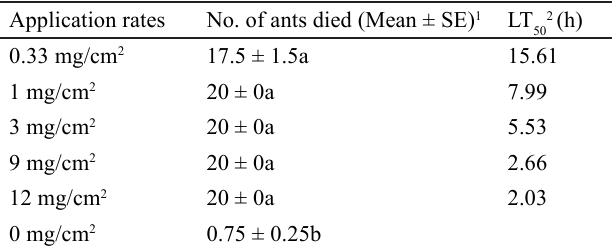
Table 1. Toxicity of sweet flag powder against Solenopsis invicta workers.